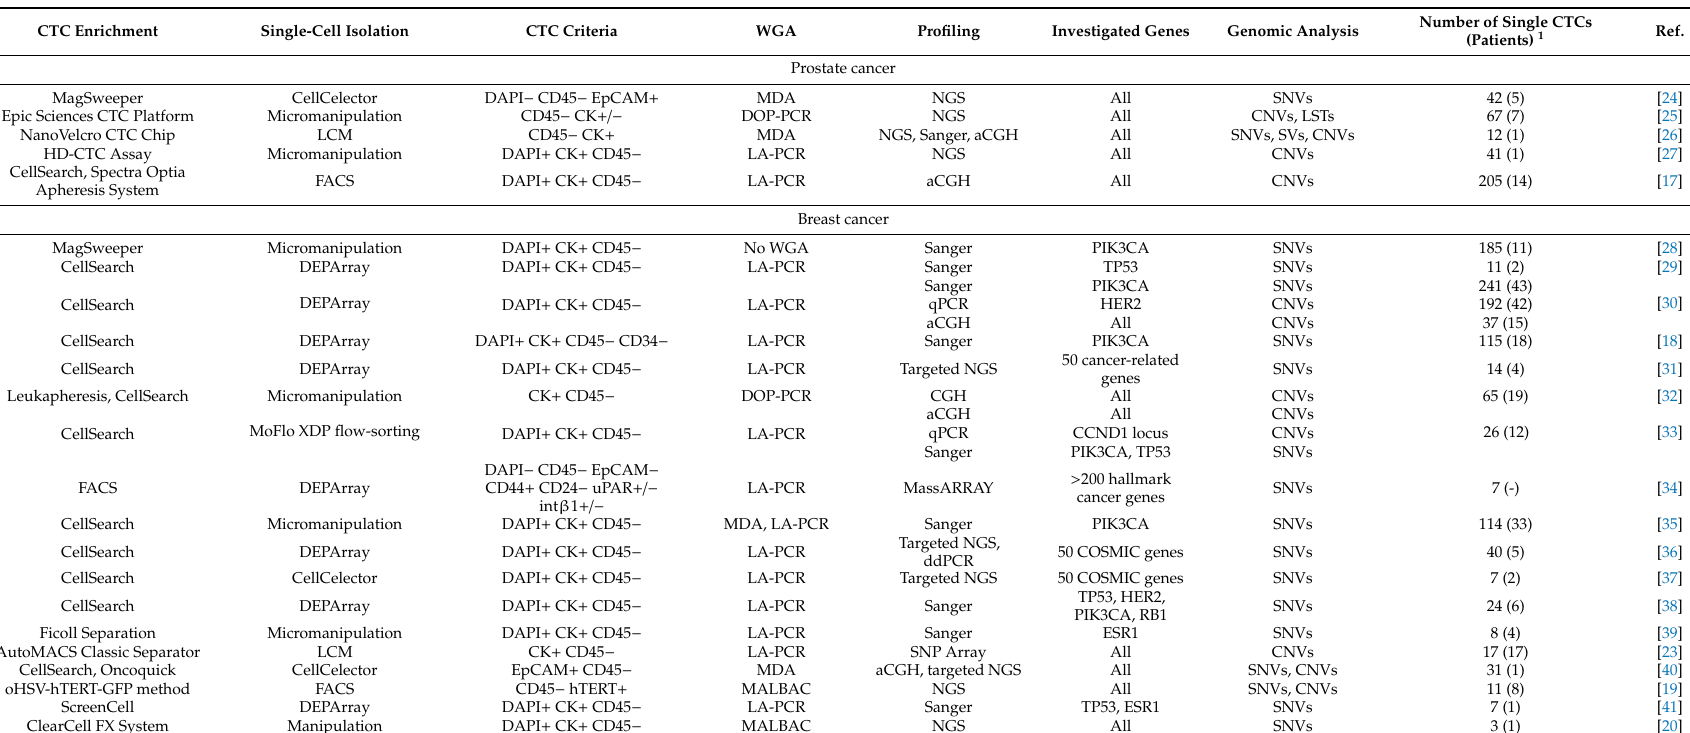
Table 1. Summary of single-cell circulating tumor cells (scCTC) sequencing studies that analyzed DNA alterations in patient-derived CTCs.